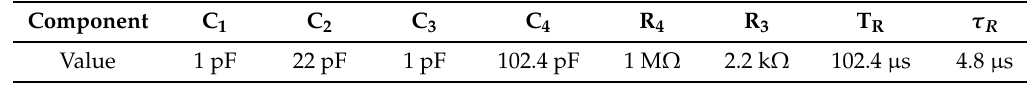
Table 1. Values of system